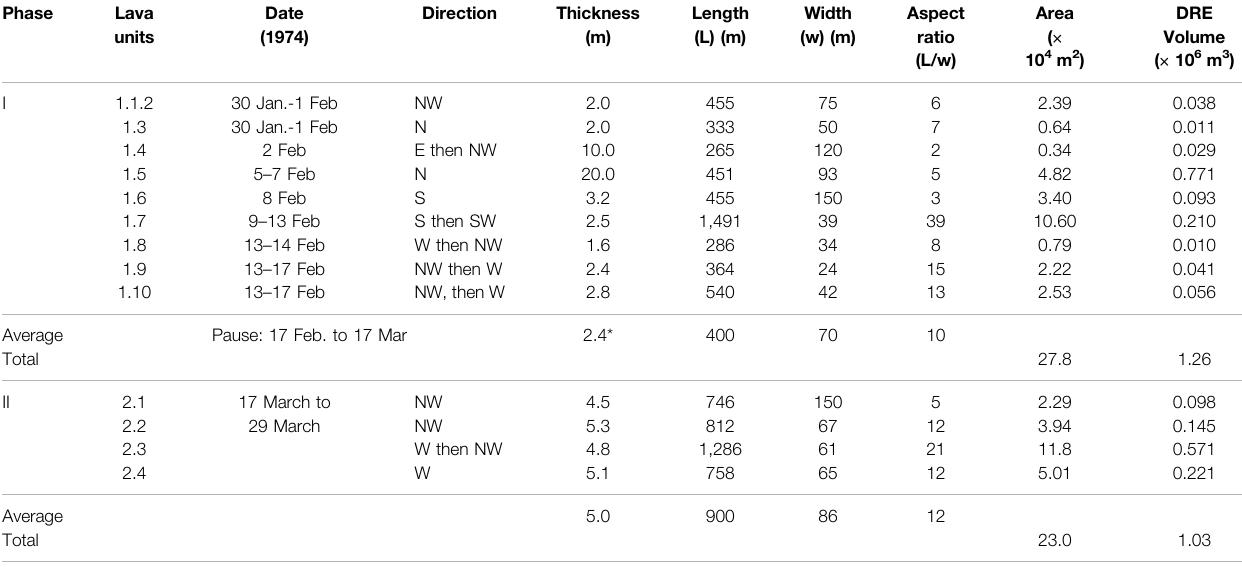
*Calculated excluding units 1.4 and 1.5 which were associated with collapse events.